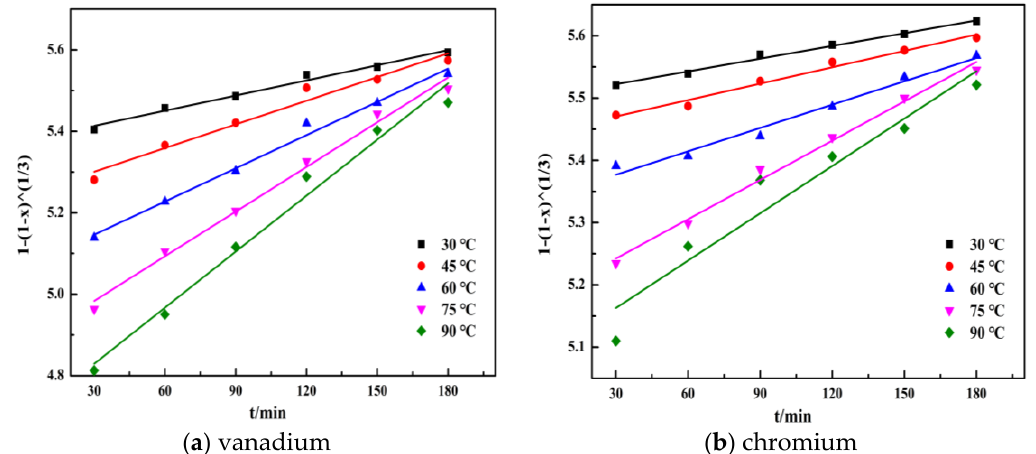
Figure 9. Plot of leaching kinetics of vanadium at various reaction temperatures in different leaching processes.